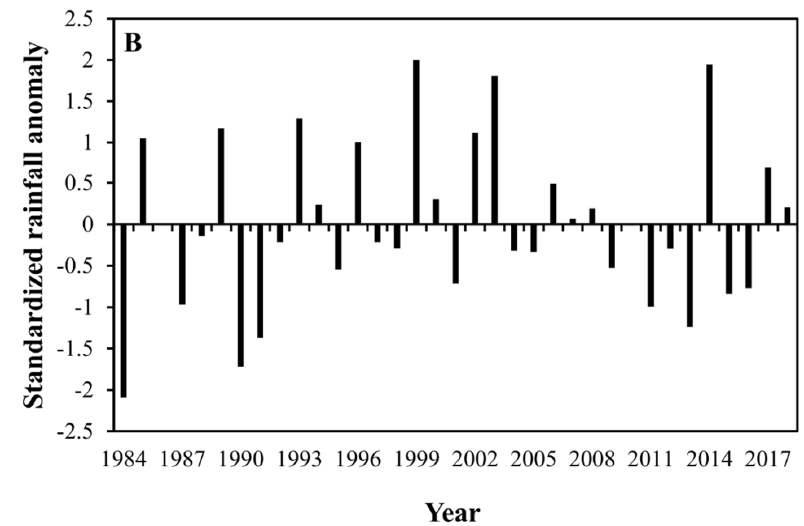
Figure 6. Standardized anomaly index for mean temperature ( A ), and annual rainfall ( B ) in Gedaref State, Sudan from 1984 – 2018.